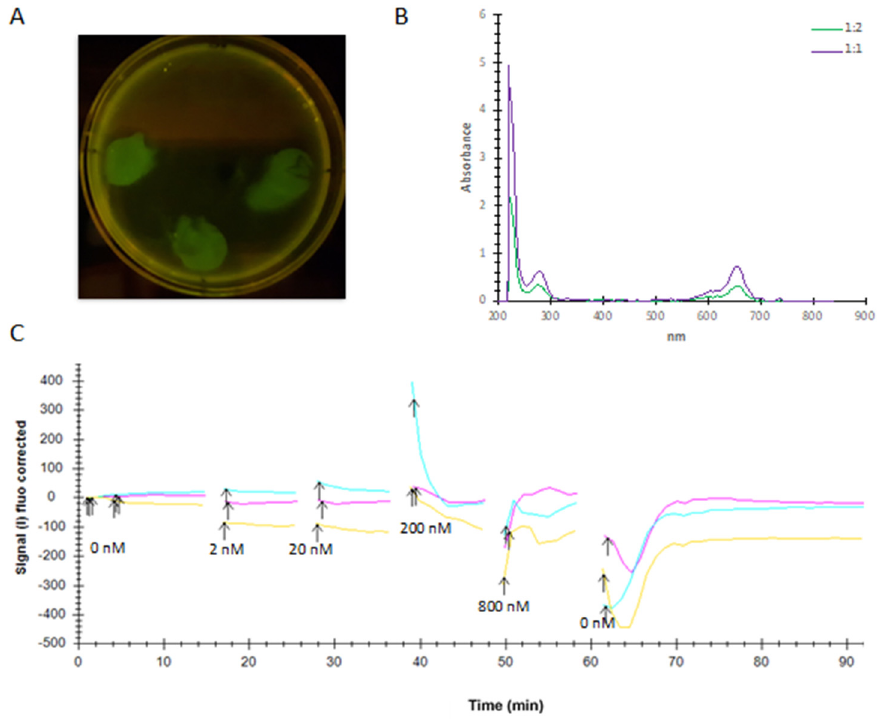
Figure 7. LigandTracer experiment. ( A ) Fluorescence of tethered Sf9 cells confirms expression of pFastBac-PTCHD1-CVGH on three distinct spots on the Petri dish. The control spot (top) shows no fluorescence. ( B ) Absorbance trace of 1:1 and 1:2 ShhN labelled with DyLight™ 650. Clear absorbance peaks can be seen at 220, 280, and 650 nm. ( C ) Triplicate ligand binding (15–60 min) and dissociation (60–90 min) traces. Signal intensity has been normalized to the background signal (i.e., signal trace of control cells). Arrows indicate changes in ShhN